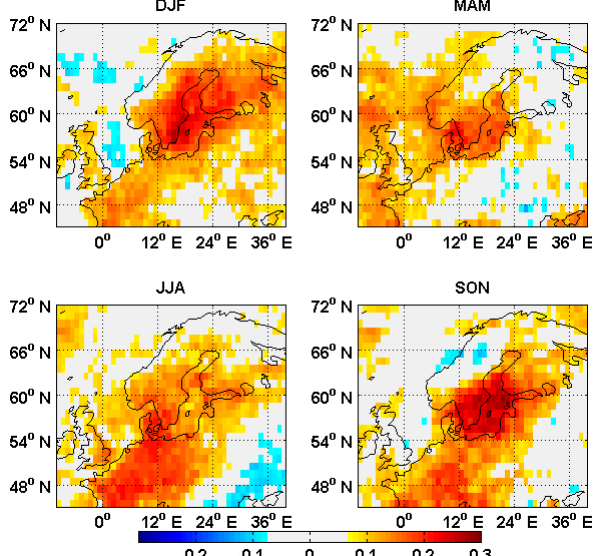
Figure 8. Total cloud fraction anomalies observed during extreme events based on AIRS data.